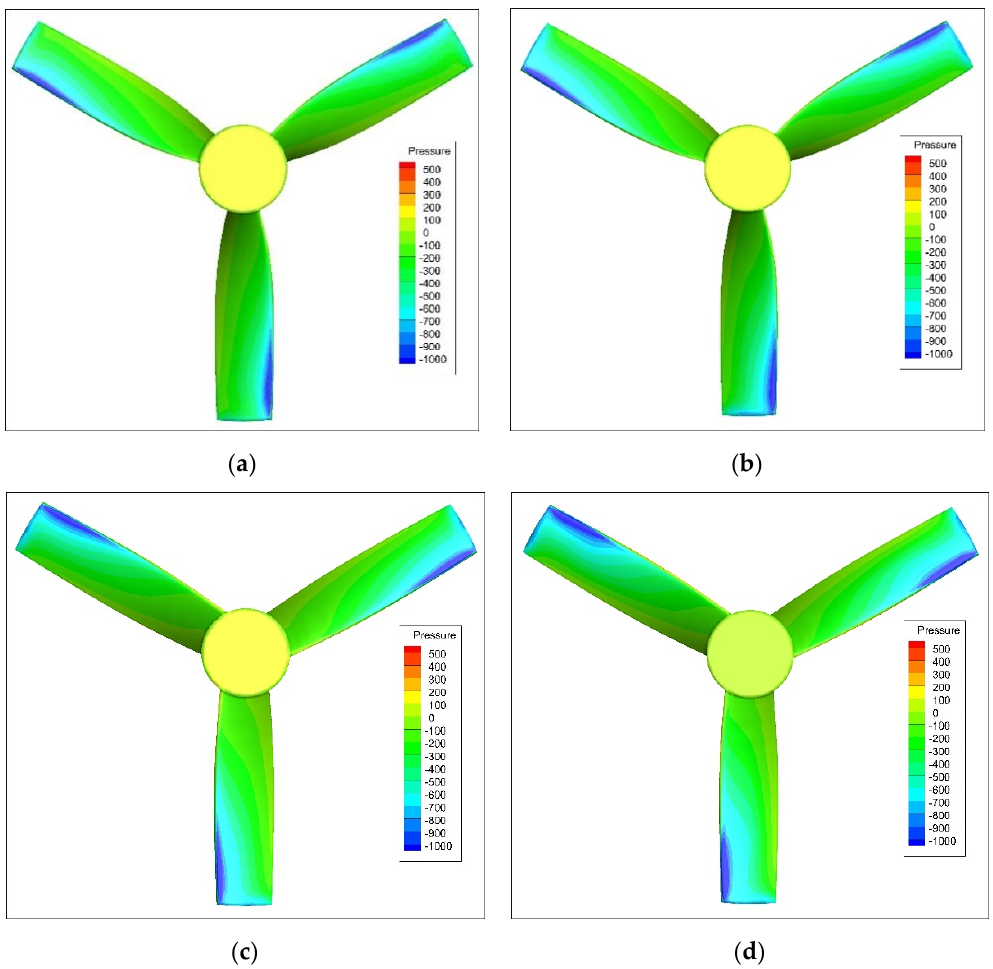
Figure 6. Calculated static pressure contours of single and coaxial propellers: ( a ) Single upper propeller; ( b ) Coaxial upper propeller; ( c ) Single lower propeller; ( d ) Coaxial lower propeller.